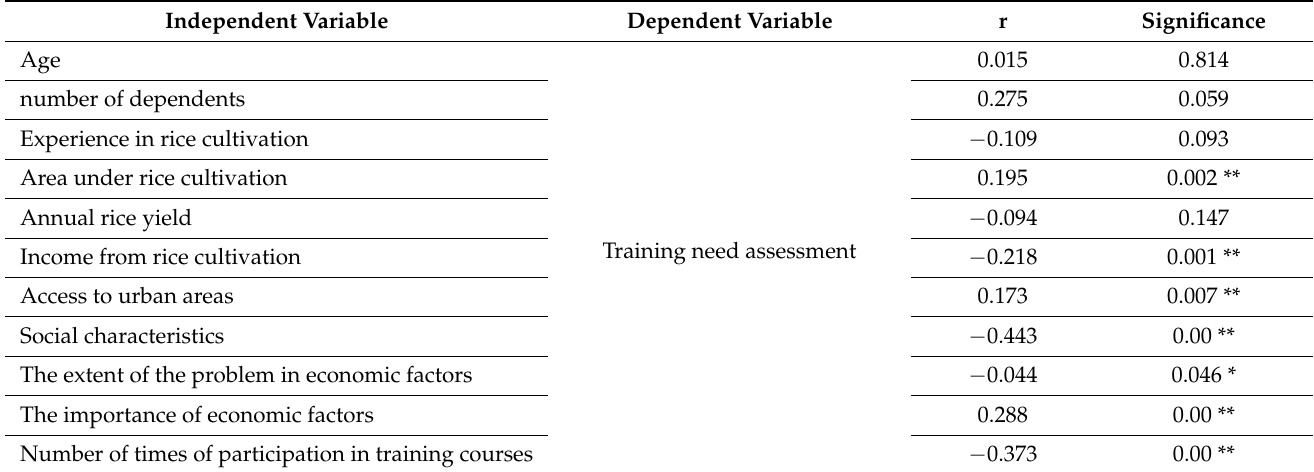
Table 2. Results of the Spearman correlation coefficient.